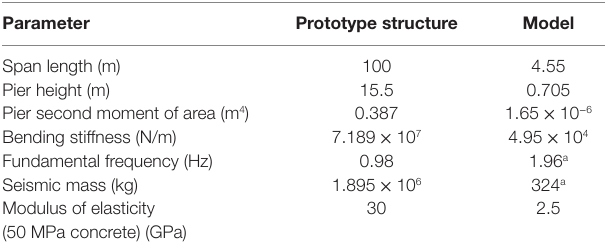
TaBle 2 | Dimensions and dynamic characteristics of the prototype structure and the model.